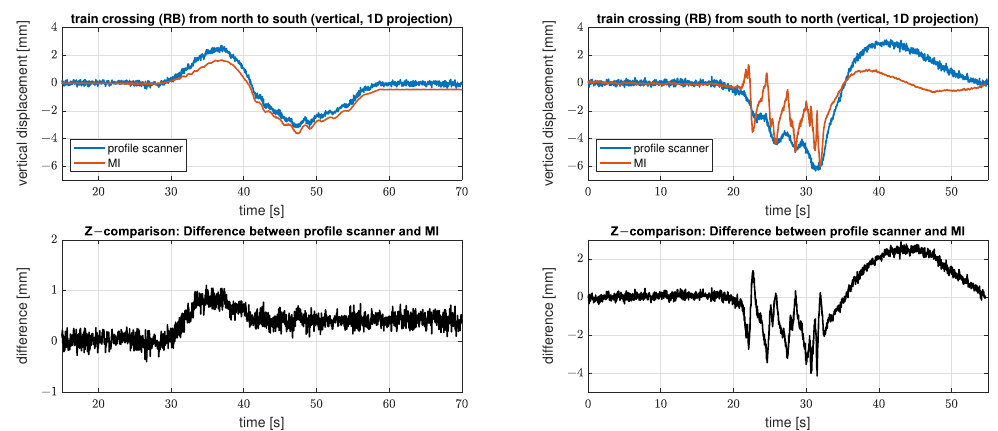
Figure 12. Comparison of the derived displacements with both measuring systems (profile scanner and MI) at cross girder 6 for setup 2 (left side) and setup 3 (right side). Line 1 shows the measurements of the IMAGER 5016 in profile mode in blue and the 1D-projected IBIS-S measurements in red, and line 2 displays the respective differences in black. Note the different scaling of the differences between the two train